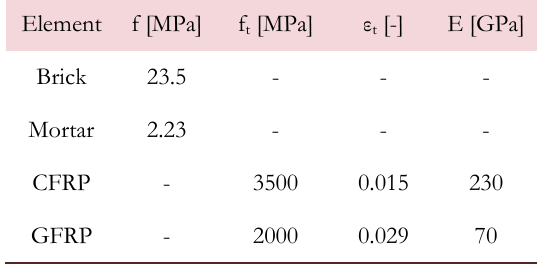
Table 8.A: Mechanical properties of constituents for the experimental tests